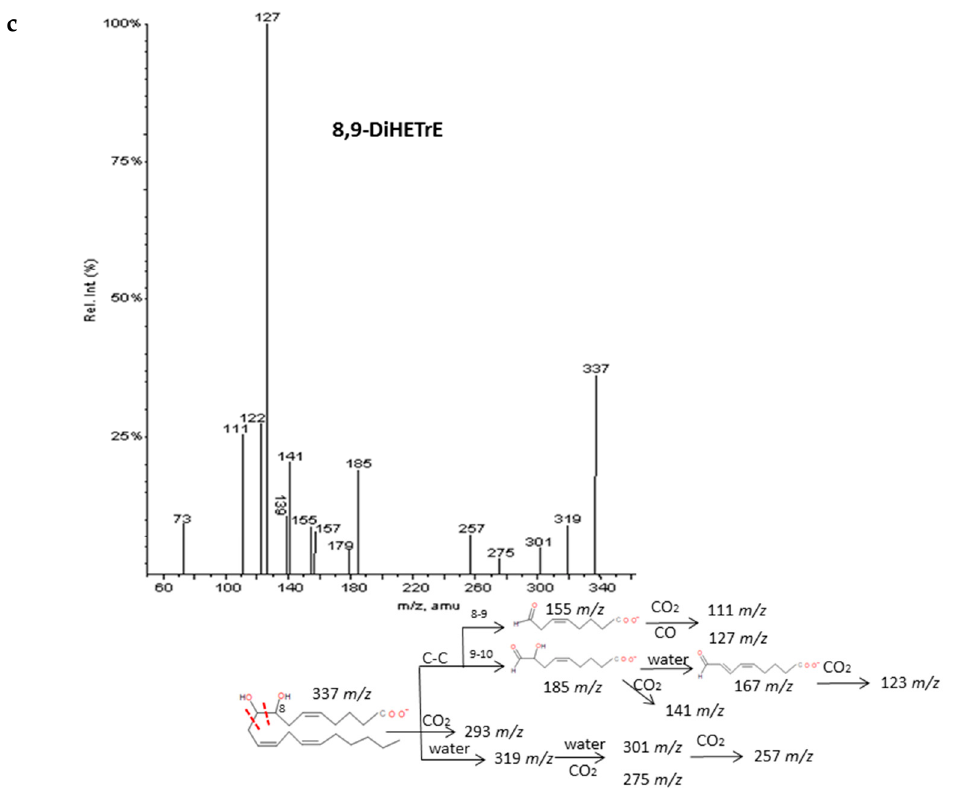
Figure 6. Fragmentation pattern suggested for ( a ) LxA 4 , ( b ) LTB 4. and ( c ) 8.9-DiHETrE. Product ion spectrum at m / z 351. m / z 335. and m / z 337 were obtained from database of LIPID MAPSat CID 30V.